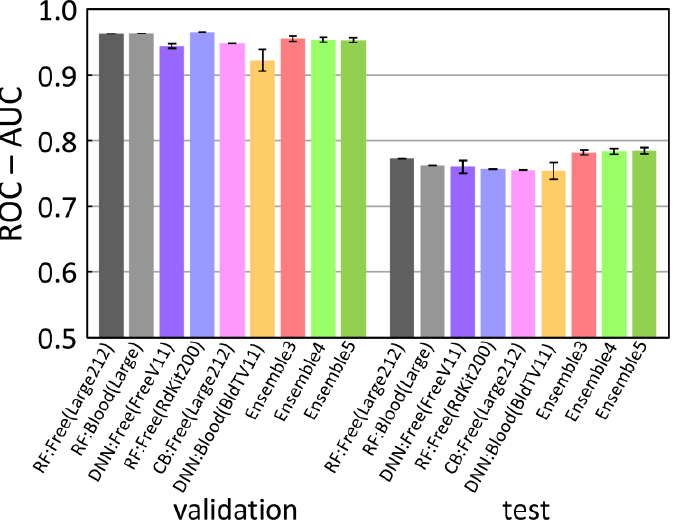
Figure 10. ROC-AUC scores of the top six prediction results and ensemble results.